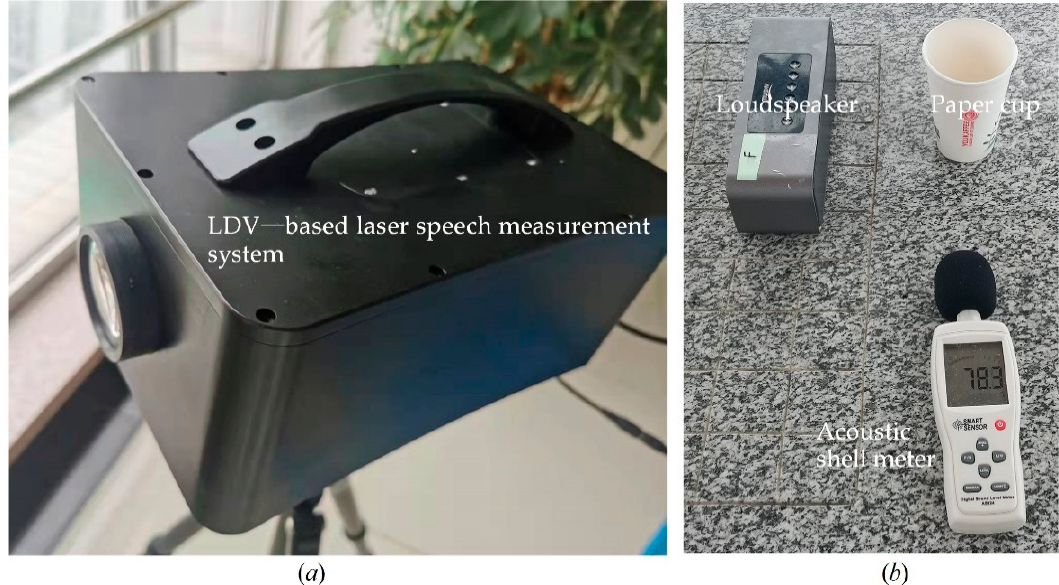
Figure 8. Real-world experiment: ( a ) The laser speech measurement system; ( b ) The loudspeaker, paper cup and acoustic level meter.